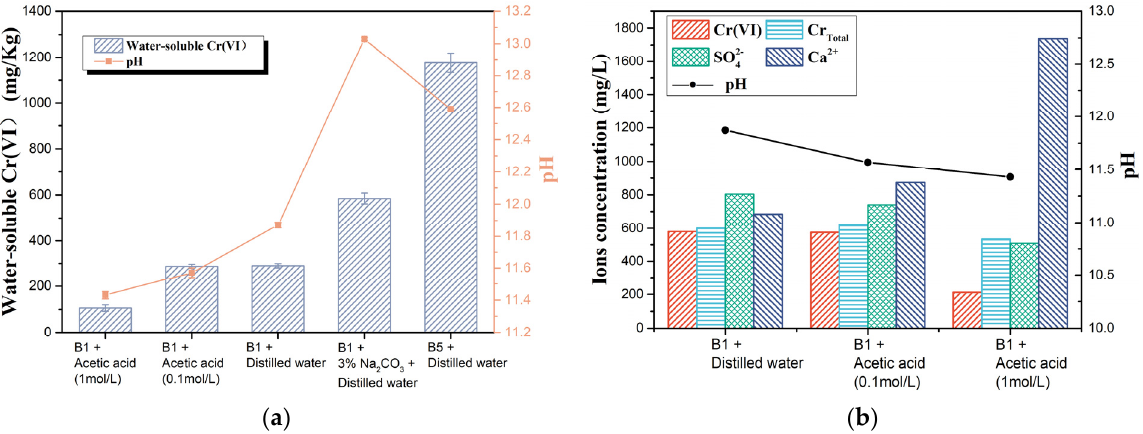
Figure 6. ( a ) Chromium concentration and pH of the filtrates of sample B1 with four kinds of extraction solvents and sample B5 and ( b ) concentrations of Cr Total , Cr(VI), Na + , Ca 2+ , and SO 42 − in the filtrates of B1 with three kinds of extraction solvents.